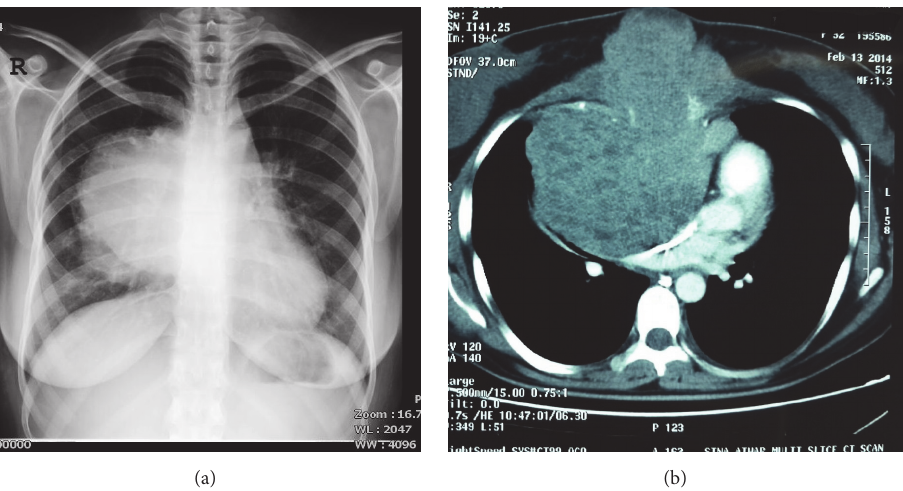
Figure 1: Preoperative chest X-ray (a) and CT scan (b) showing a large mass with multiple areas of low attenuation that has compressed the heart but without obvious invasion to vital